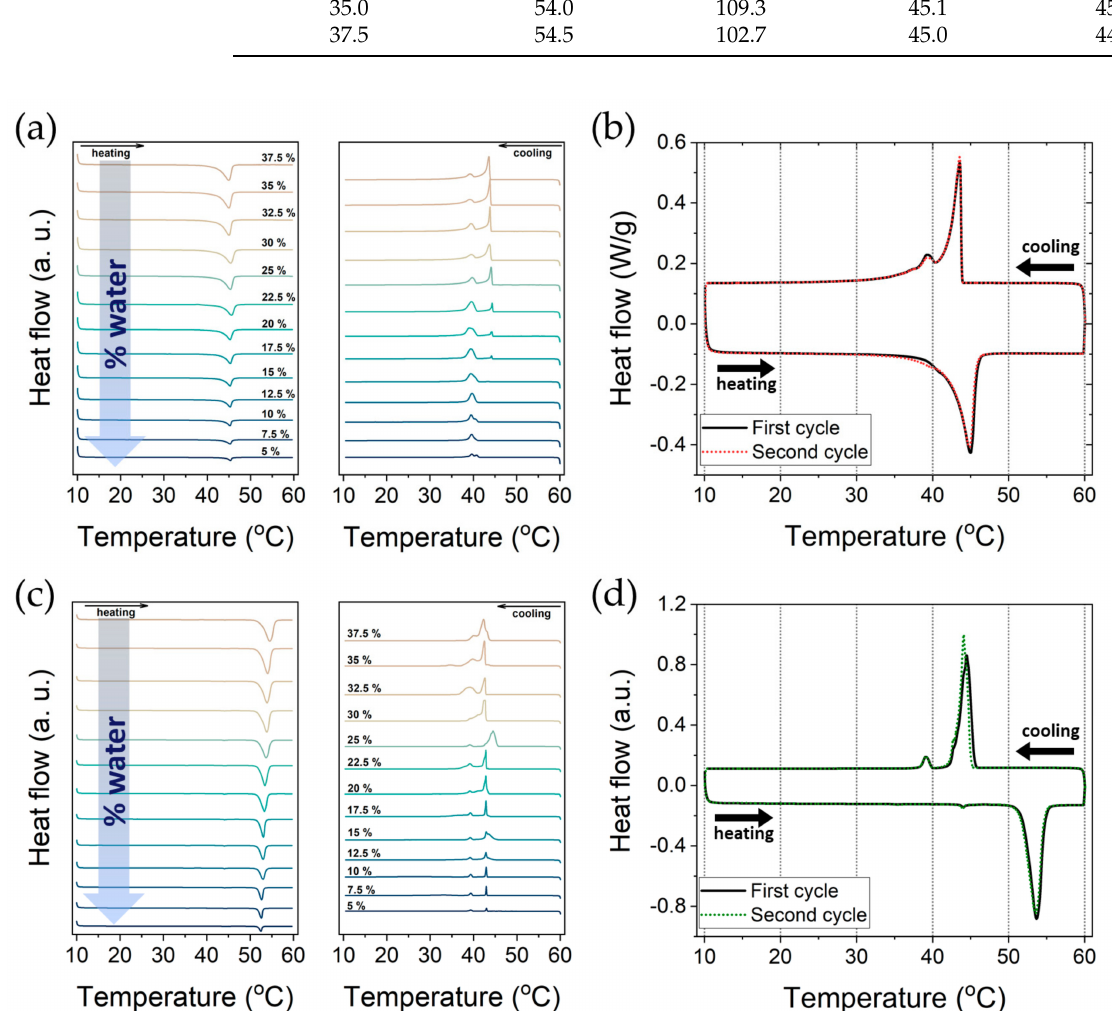
Figure 1. Thermal analysis under heating and cooling of two double-chain cationic surfactants. Thermograms from 5 to 37.5 wt% of ( a ) DODAC and ( c ) DODAB in water. Two-cycle thermograms under heating and cooling of ( b ) 35 wt% DODAC and ( d ) 25 wt% DODAB in water. The full line corresponds to the first cycle and the dotted line to the second cycle. The measurements were conducted from 10 to 60 ◦ C, and back to 10 ◦ C at 2 ◦ C/min. The endothermic event corresponds to the downwards